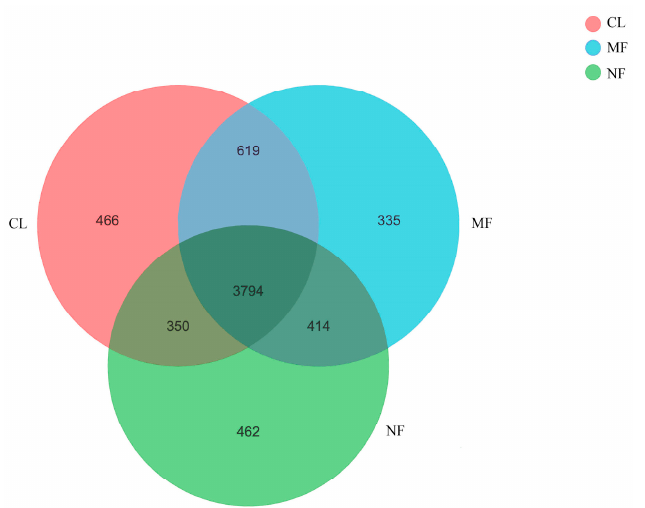
and OTU1820. The most dominant OTUs belonged to the Proteobacteria , Actinobacteriota , and Acidobacteriota phyla.